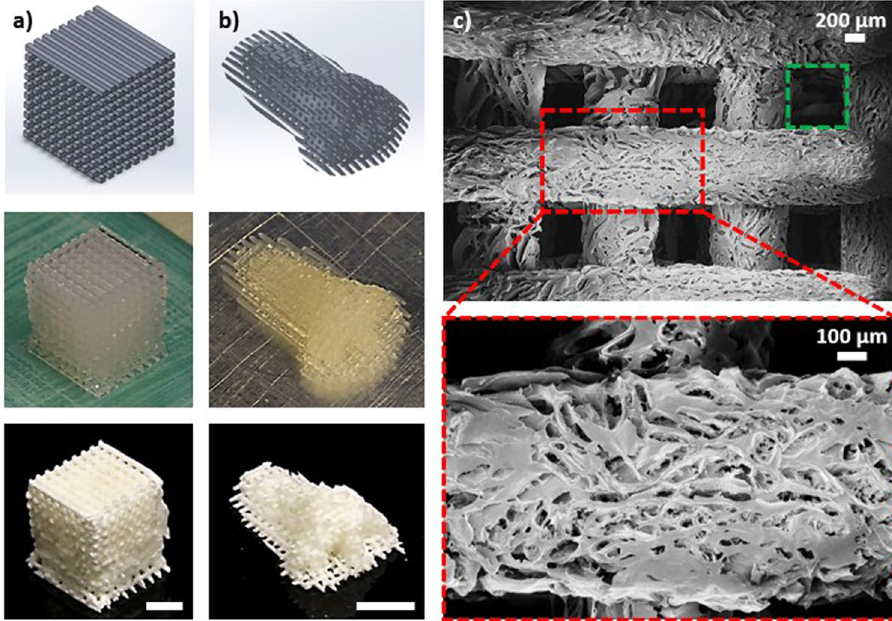
Figure 4. DIW 3D printed dual pore scaffold aerogel in a 0–90° configuration for ( a ) a cube and ( b ) a nose model. ( c ) The corresponding SEM images illustrate an average structural pore size of about 600 µ m (green box) and a random pore size distribution of 20 to 800 µ m (red box). 20 wt% CNC gel and 500 µ m nozzle tip was used. Unless specified, displayed scale bars are 1